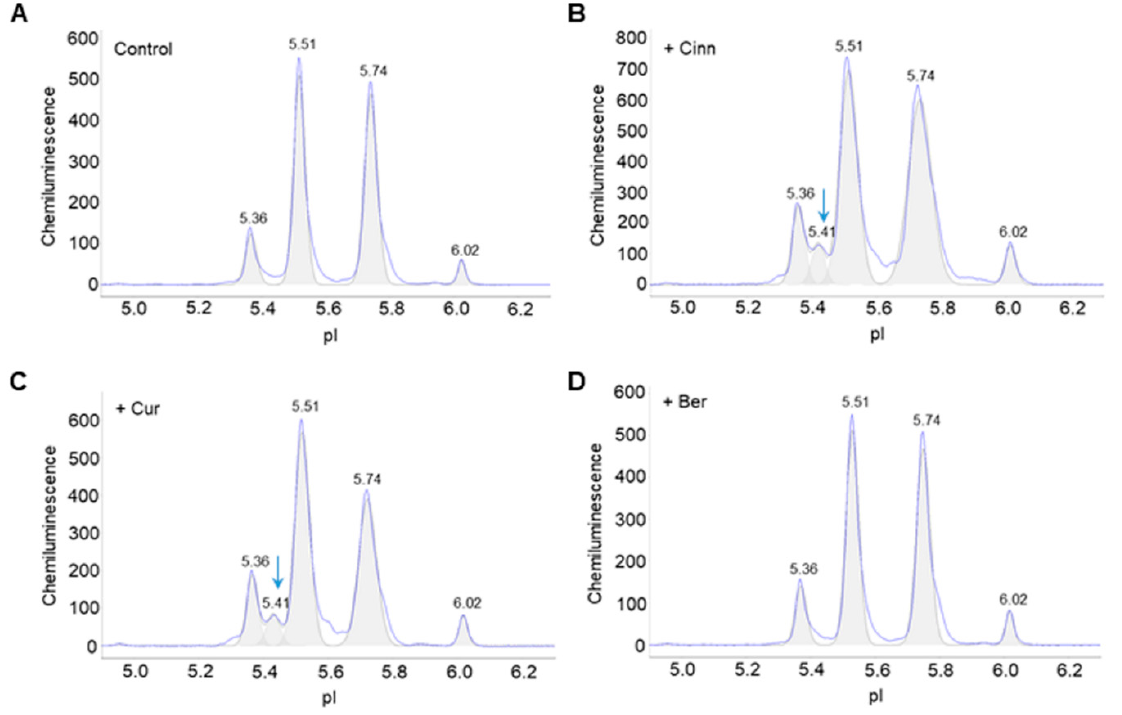
Figure 1. Cinnamaldehyde and curcumin induce changes to Akt2 post-translational modifications. Distribution of Akt2 as a function of isoelectric points in ( A ) control untreated preadipocytes, or ( B – D ) preadipocytes treated with ( B ) cinnamaldehyde, ( C ) curcumin, or ( D ) berberine. Arrows point to the appearance of new peaks following treatment versus untreated